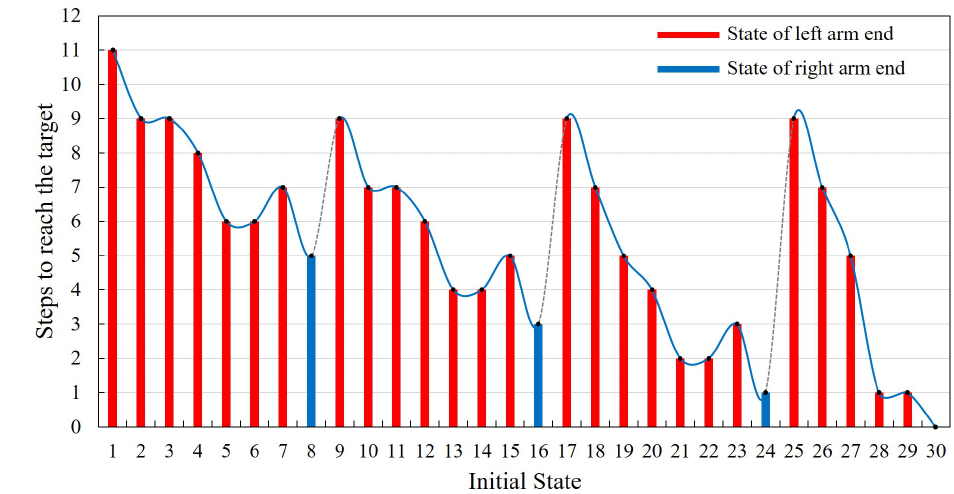
Figure 8. The number of steps required for the AstroLimbs to reach the target from different state